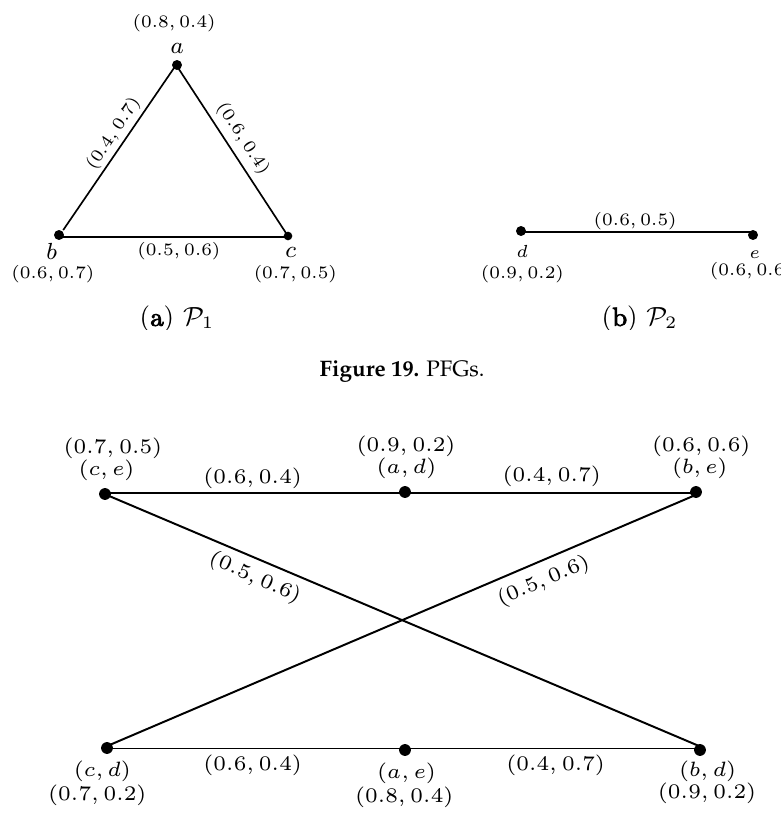
Figure 4.5: Residue Product of two PFGs.